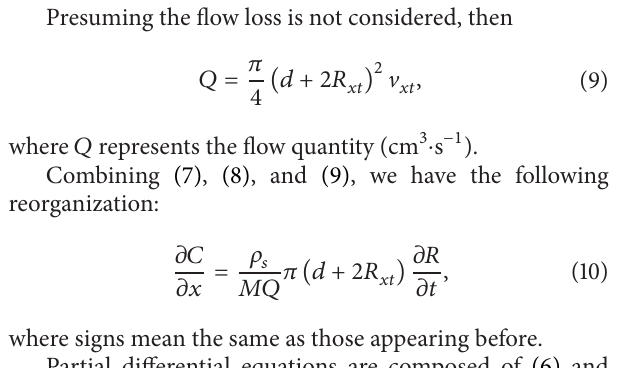
the dissolving thickness of the rock salt interface (cm), and 𝑑 represents the diameter of the pinhole